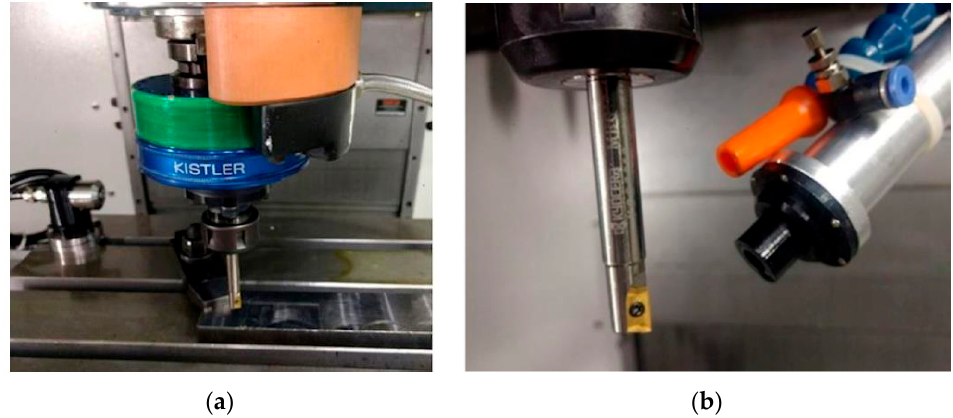
Figure 7. ( a ) The KISTLER rotary dynamometer. ( b ) the tool and the mounted valve.